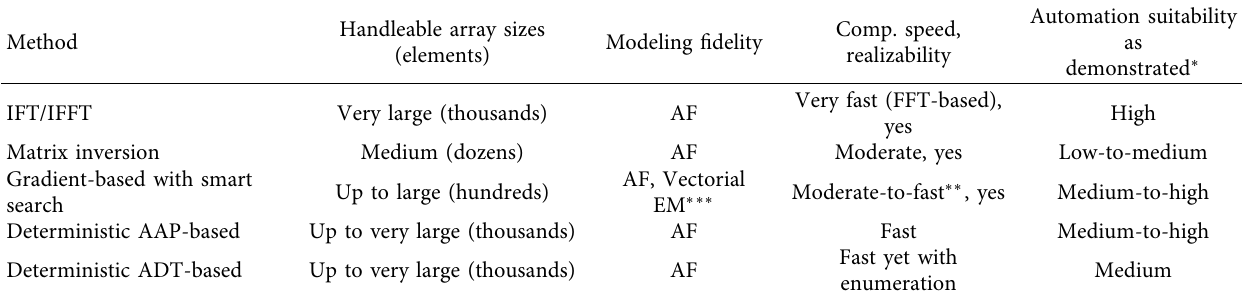
Figure 17: Selected radiation patterns at 10GHz of the array shown in Figure 16 as obtained by phase-only synthesis [77]: (a) E-plane boresight array pattern, as simulated (-) and measured (); (b) E-plane array pattern scanned to 40 degrees, as simulated (-) and measured (); (c) SLL versus scan angle based on the synthesized scan-specific phase tapers ( ── ), with the phase taper optimized for boresight radiation ( ─ ─ ), with uniform taper ( ▪▪▪ ); (d) realized gain scan loss with the synthesized scan-specific phase tapers ( ── ), with the phase taper optimized for boresight radiation ( ─ ─ ), with uniform taper ( ▪▪▪ ). Table 2: Alternative methods for phased antenna array synthesis: a qualitative comparison.